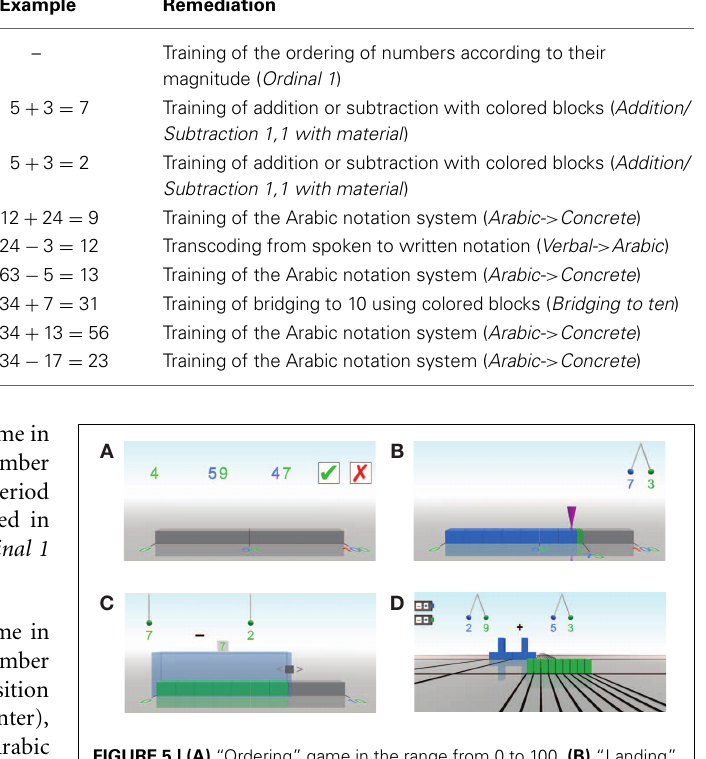
FIGURE 5 | (A) “Ordering” game in the range from 0 to 100. (B) “Landing” game in the range from 0 to 100. (C) “Slide rule” game in the range from 0 to 10. (D) Example task of the “Plus and Minus”